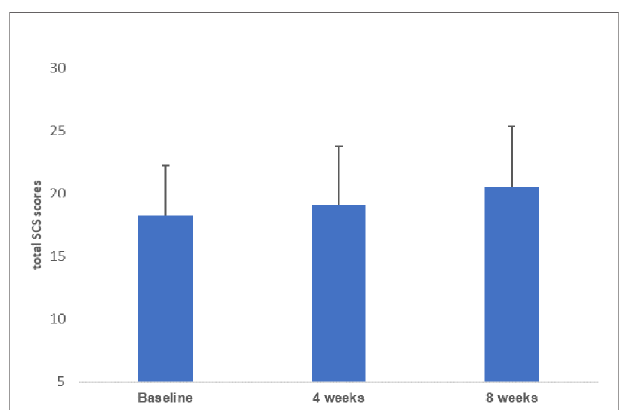
FIGURE 1 | Changes in total self-compassion scale (SCS) scores from baseline to 8 weeks. The mean total self-compassion scale scores improved signi fi cantly from baseline to 8 weeks post-MBI. MBI, mindfulness-based intervention.